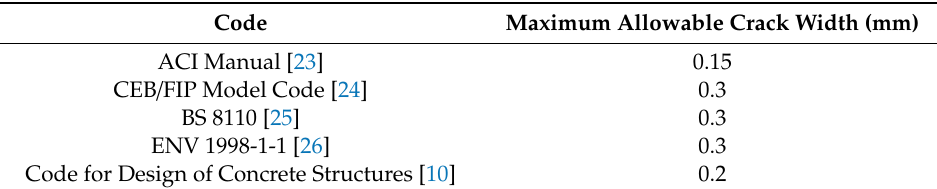
Table 3. Load value of the beams. Table 2. Maximum allowable crack width set by various codes.